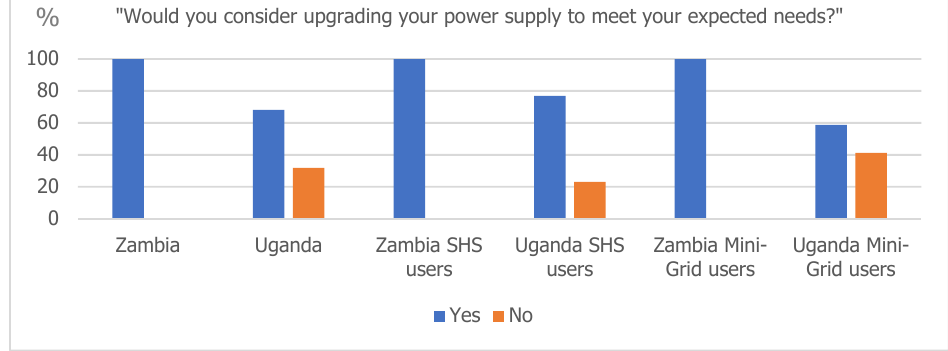
Figure 7. Desire for upgraded electricity supply Consumer Groups in Uganda and Zambia (Re- sponses in %; N = 1037).